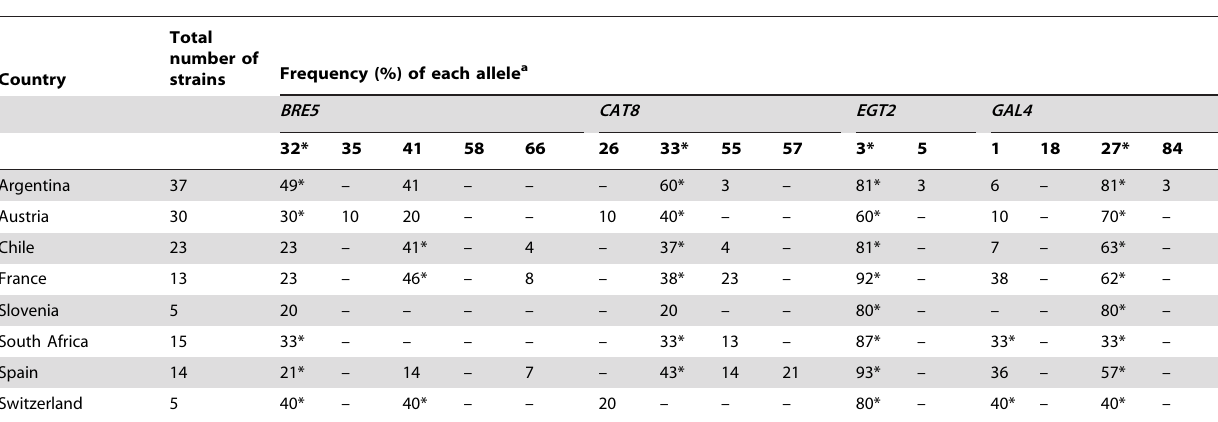
Table 1. Frequency of wine strains isolated from different countries showing the same alleles found in hybrids.